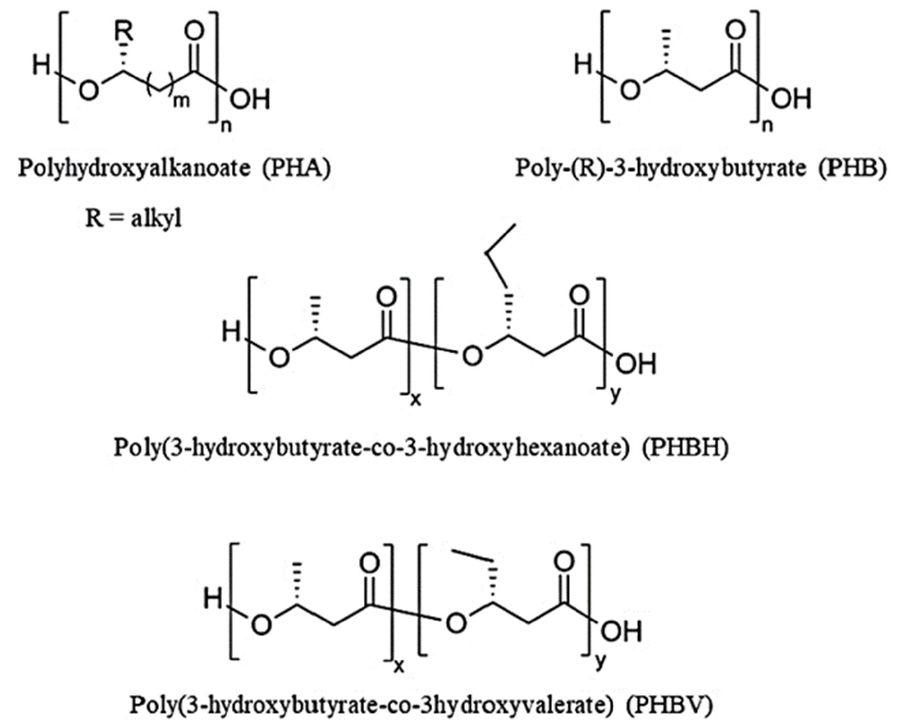
Figure 5. Molecular structure of PHAs available at an industrial scale.